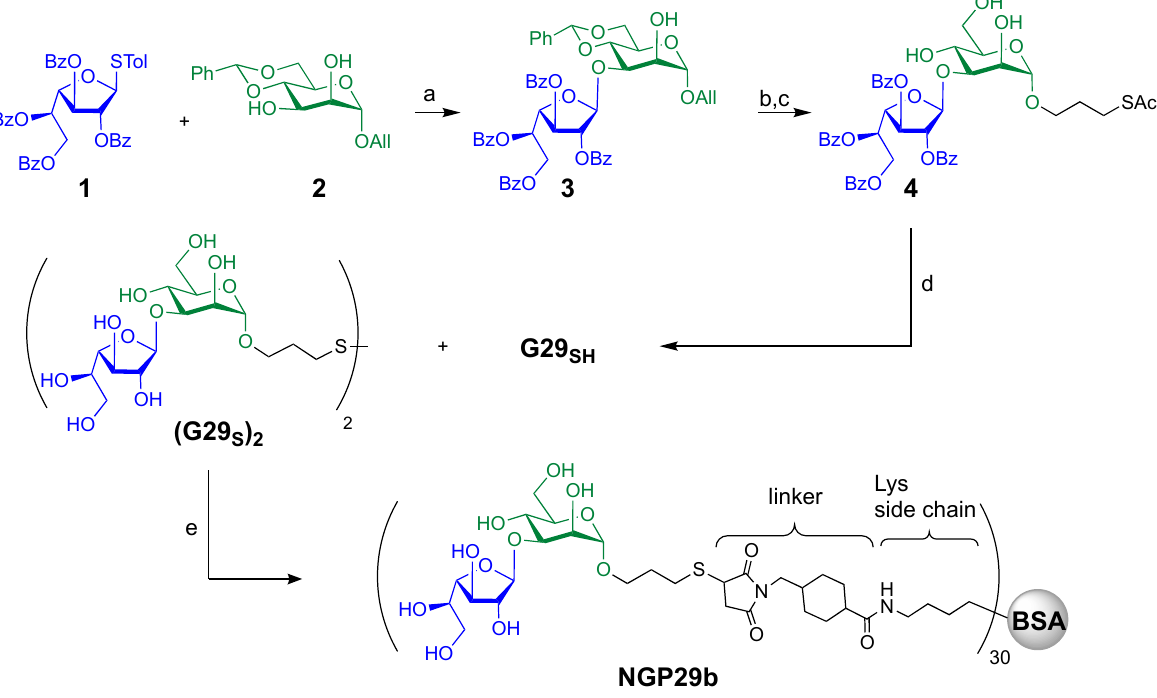
Scheme 1. Synthesis of disaccharide G29 SH and its conjugation to BSA affording NGP29b : (a)